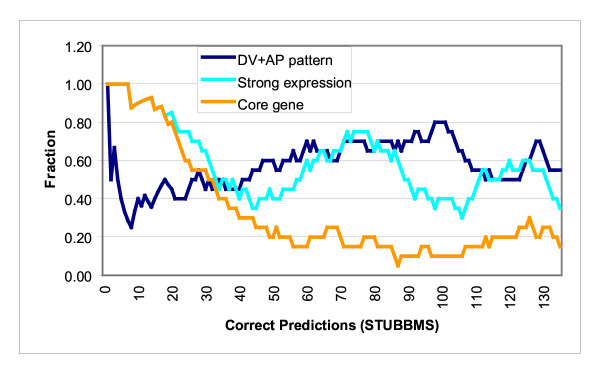
Annotation of blastoderm patterned genes predicted by STUBBMS. "DV+AP pattern": Genes with dorso-ventral aspect of pattern, in addition to anterior-posterior pattern. "Strong expression": Genes with strong expression. "Core gene": A set of 48 genes experimentally known to be required for segmentation. The x-axis represents correctly predicted genes. Each point represents, for a moving window of 20 correctly predicted genes, the fraction of genes in the appropriate category.